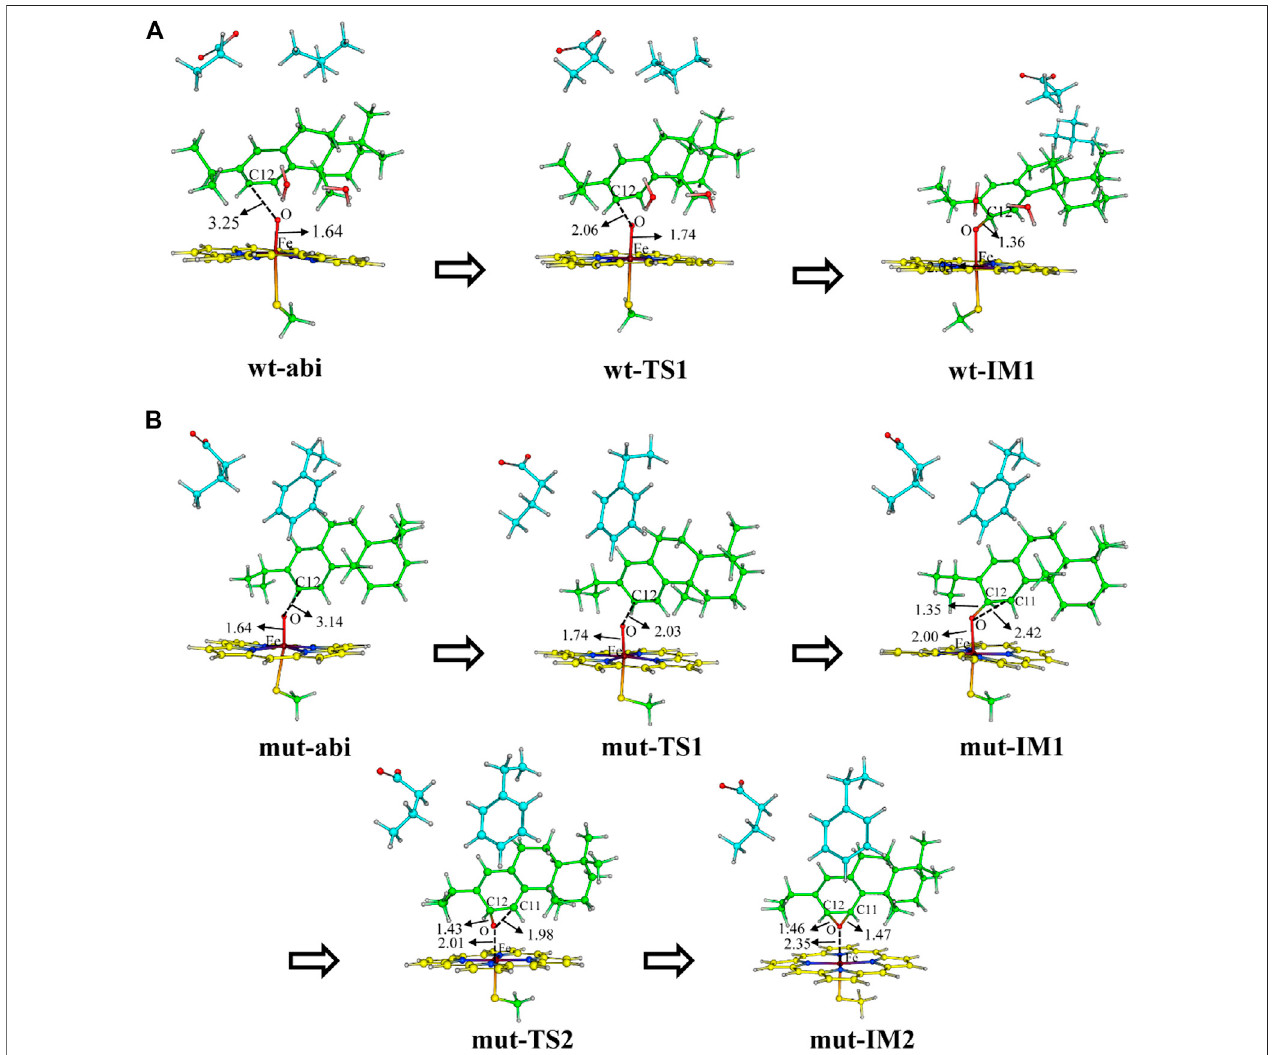
FIGURE 9 | DFT optimized structures of along reaction for the two systems (A) wt-abi and (B) mut-abi.